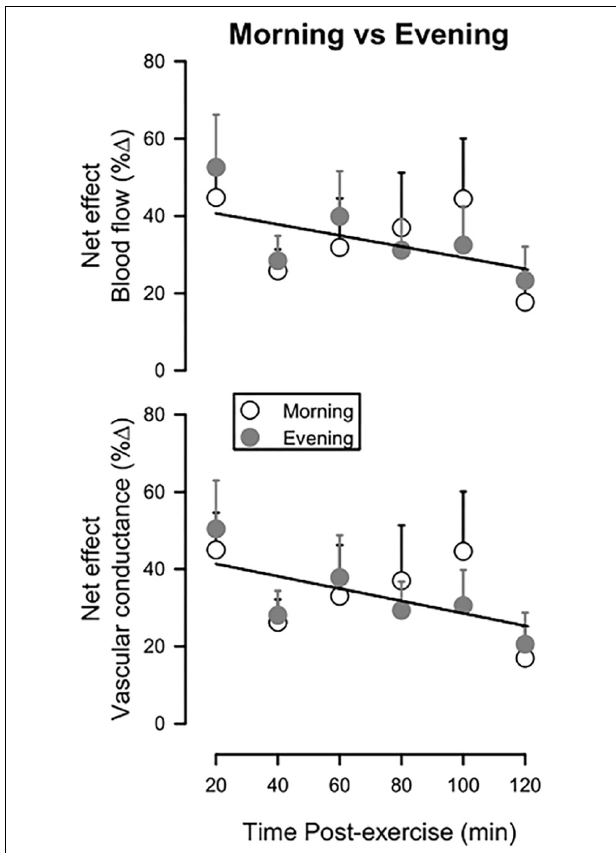
FIGURE 2 | Net effect for leg blood flow (upper panel) and leg vascular conductance (lower panel) during 120 min of recovery from exercise, expressed as a percent change between the Active Leg and the Inactive Leg, referenced to pre-exercise values. Open circles: Morning session; Filled circles: Evening session. Solitary regression lines for the net effect for blood flow and vascular conductance indicate the absence of differences between Evening and Morning sessions. Means ± SE; n =